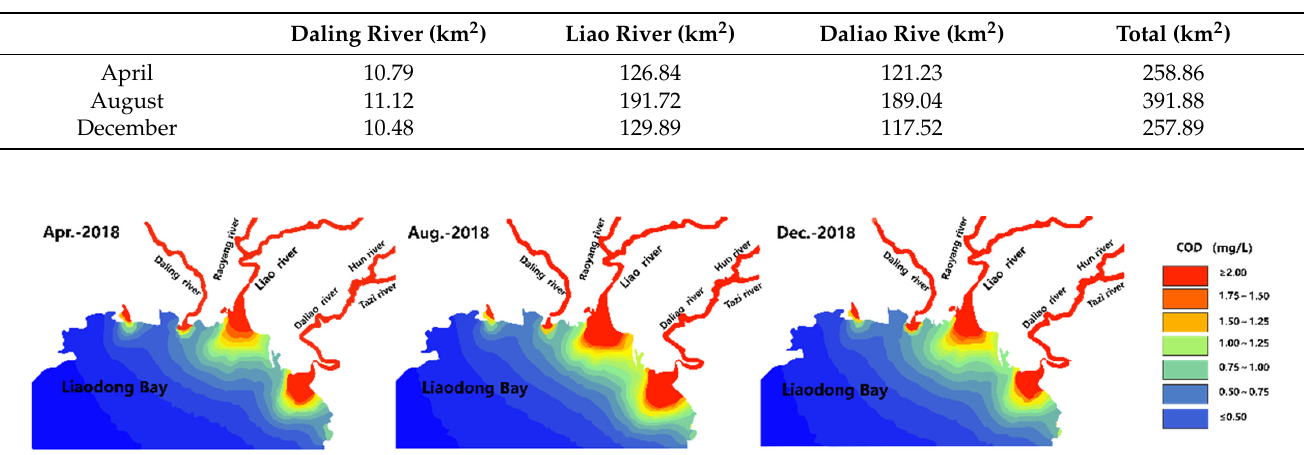
Figure 6. Measured and simulated situations of sea area points A1, A2 and A3.